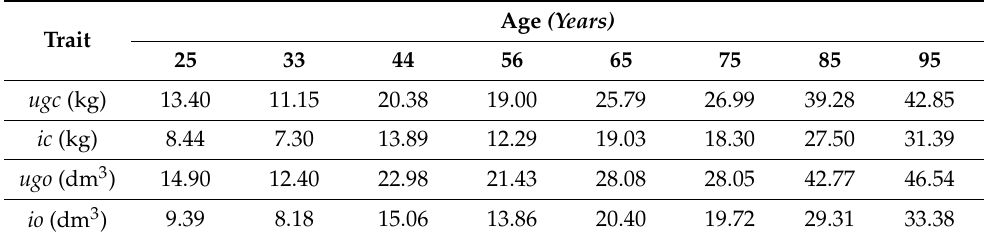
Table 4. Arithmetic means for the size of the assimilatory apparatus.